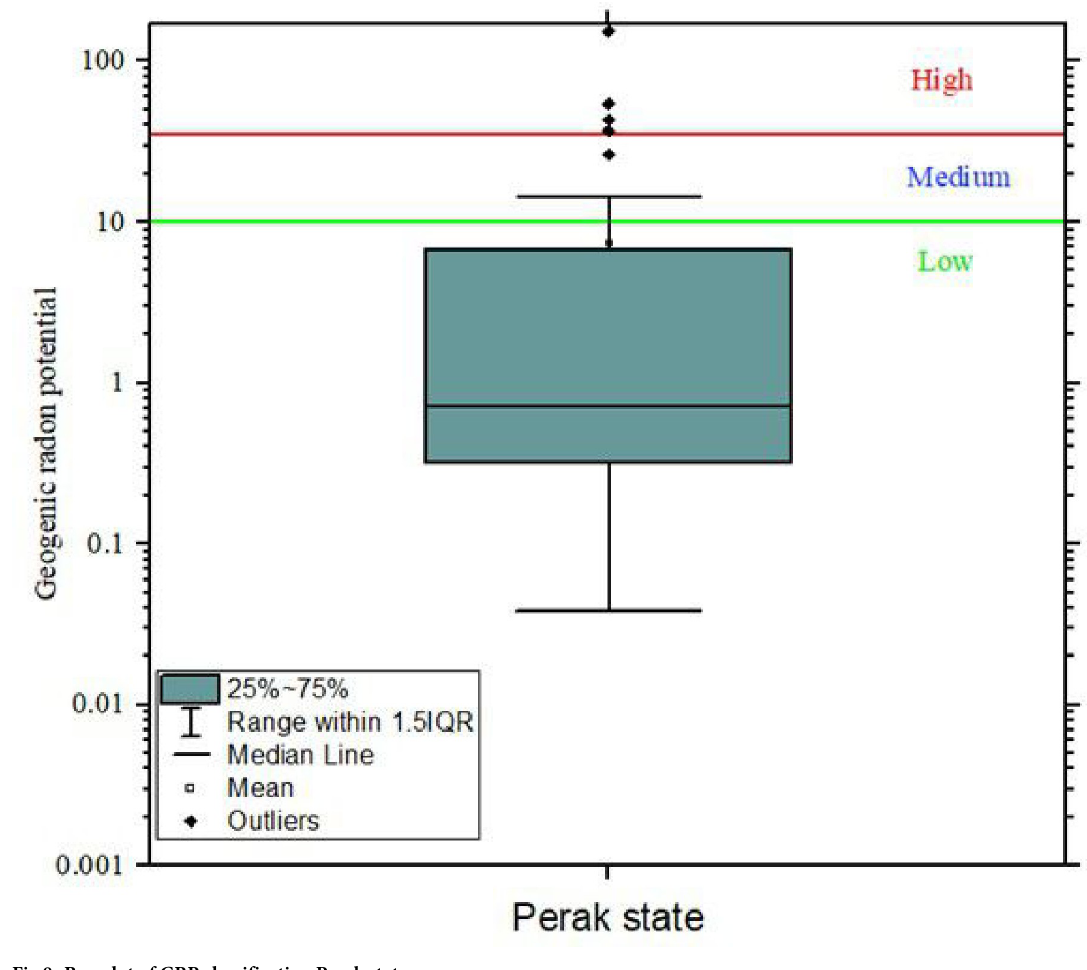
Fig 8. Box plot of GRP classification Perak